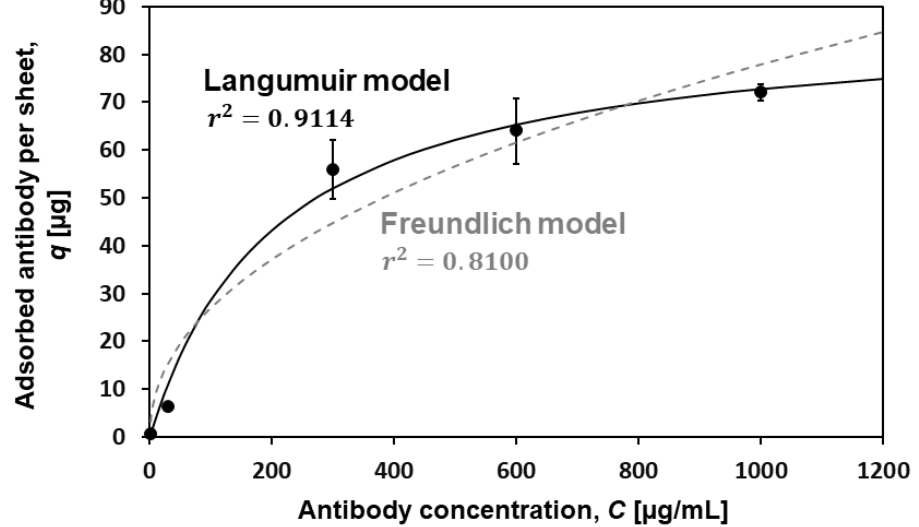
Figure 7. Quantitative evaluation of the antibody captured on the CA/PVA + PA NF based on the Langmuir adsorption model (black solid line) and Freundlich model (gray dotted line). ( n = 3).